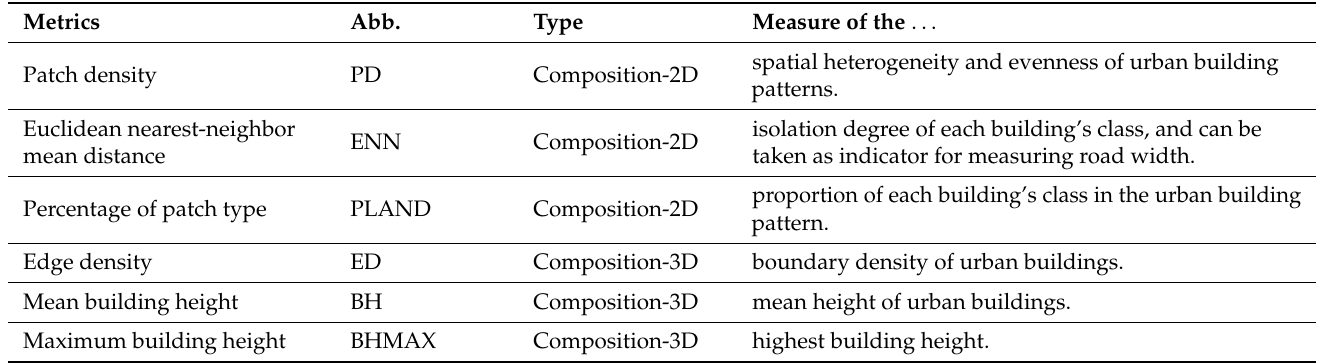
Table 1. Selected 3D landscape metrics for measuring urban morphology. For detailed calculation steps, please see literature